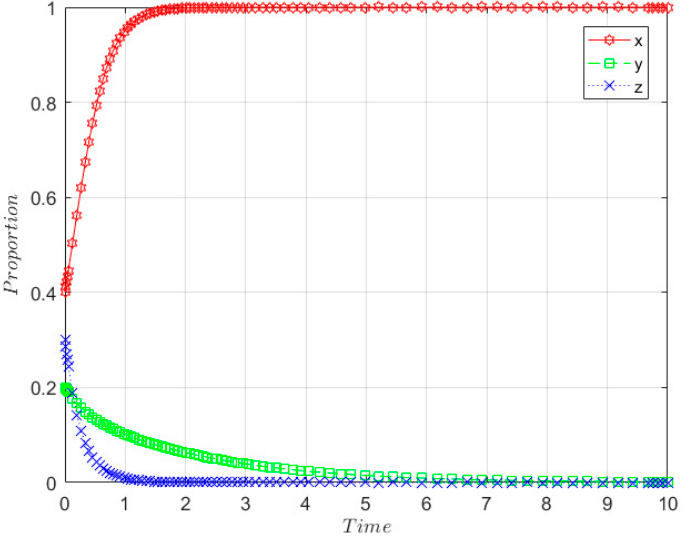
Figure 3. Evolution path of stability point E 2 (1, 0, 0) in the early development stage.